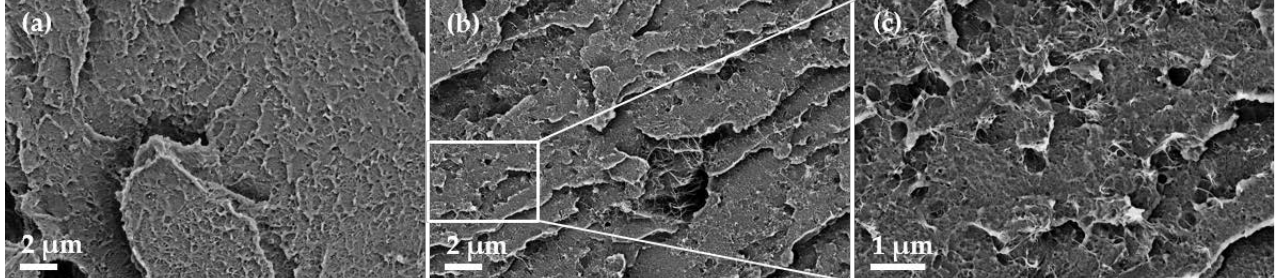
Figure 4. SEM image of PC composites with 2 wt% SWCNT ( a ) and PC with 2 wt% SWCNT + 5 wt% PVP ( b , c ).